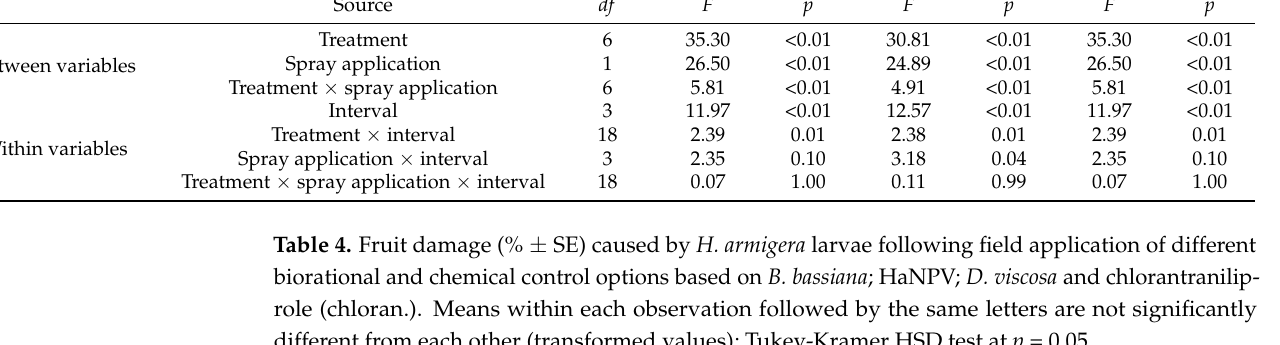
Table 3. Repeated measures MANOVA parameters for main effects and associated interactions for tomato fruit damage caused by H. armigera larvae (total df = 125). Region Rawalpindi Faisalabad Bahawalpur Source df